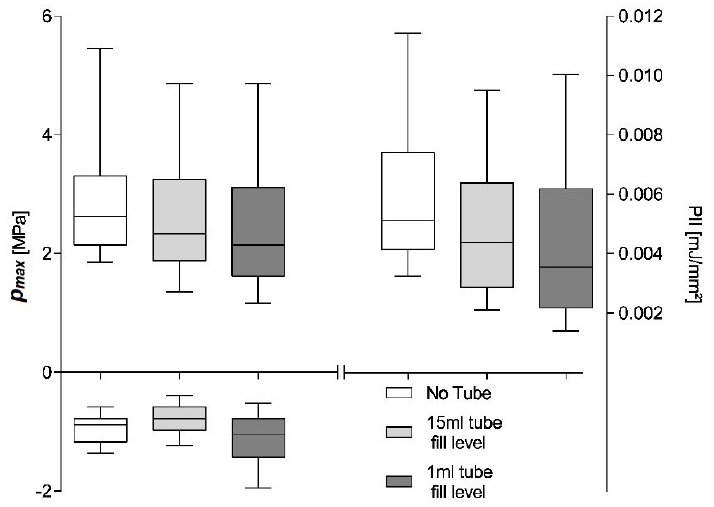
Figure 6. Comparison of positive and negative peak pressure and pulse integral intensity within a fully and partially filled (1 mL) 15 mL Falcon tube to a free-field reference (no tube). All sample medians are highly statistically different (Kruskal–Wallis, p << 0.001).